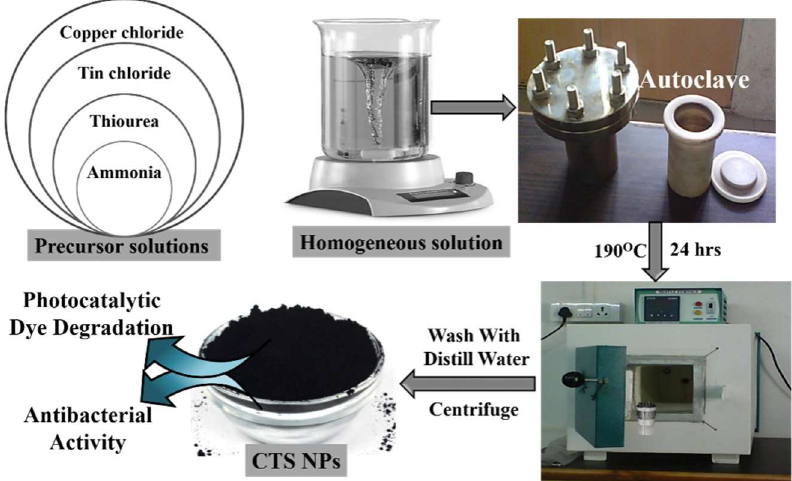
Figure 1. Schematic representation of hydrothermal deposition method of CTS NPs and its applica-